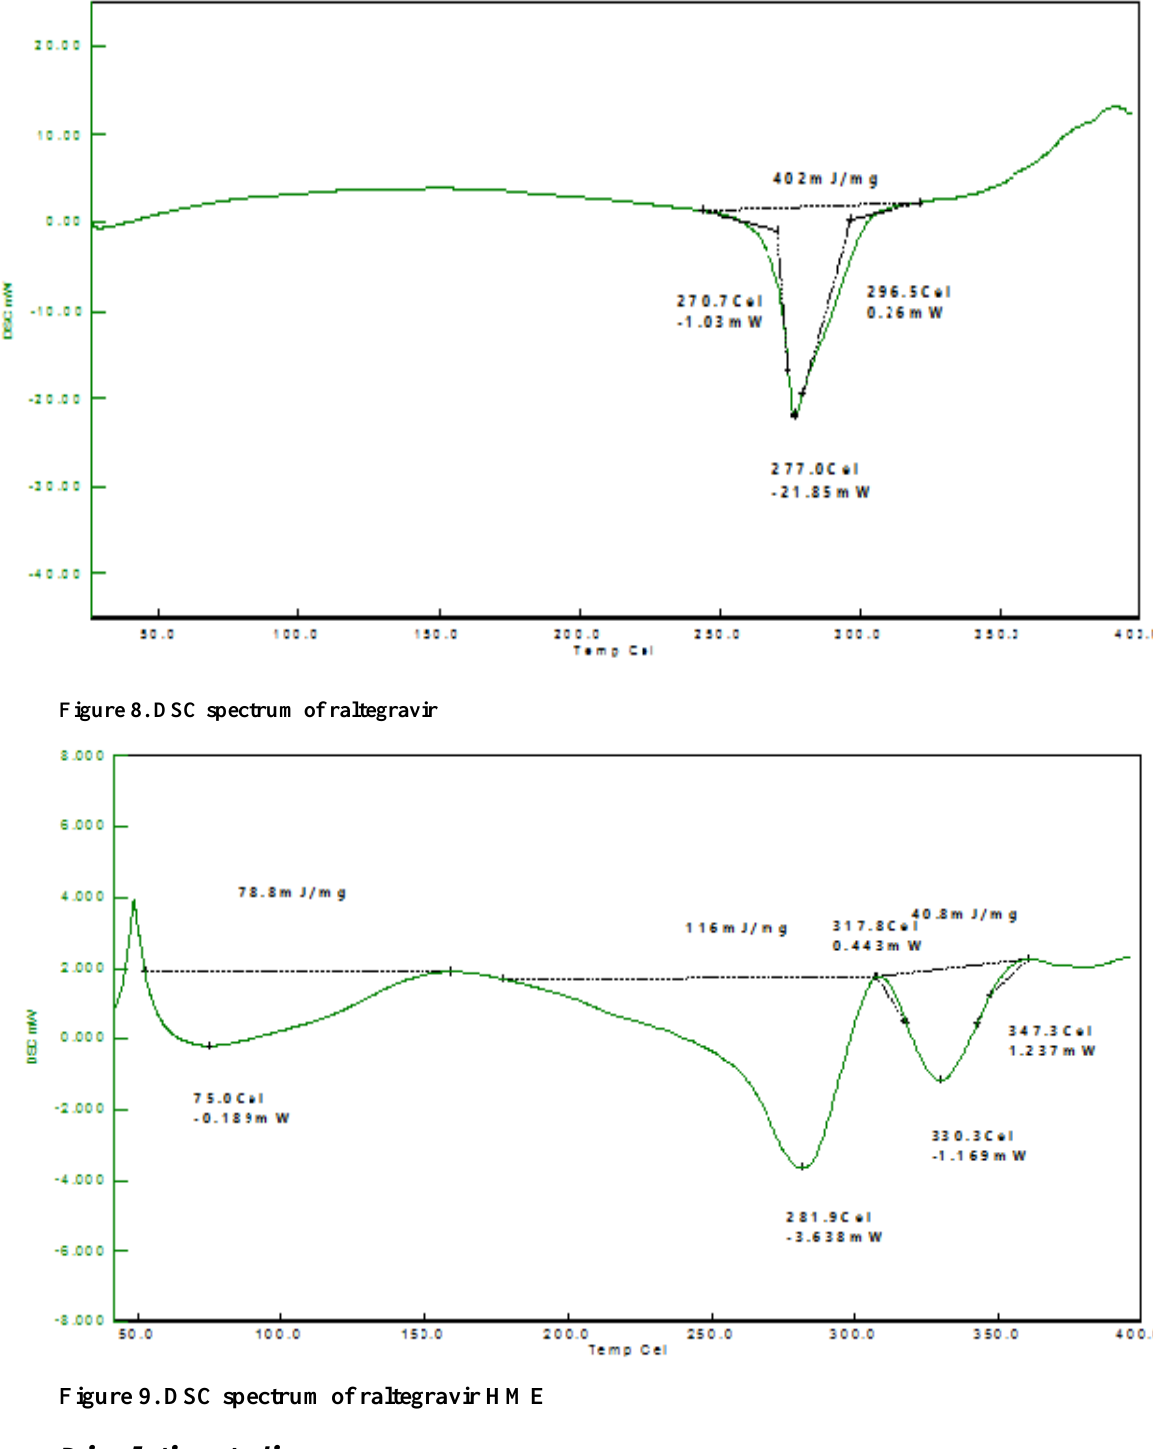
Figure 9. DSC spectrum of raltegravir